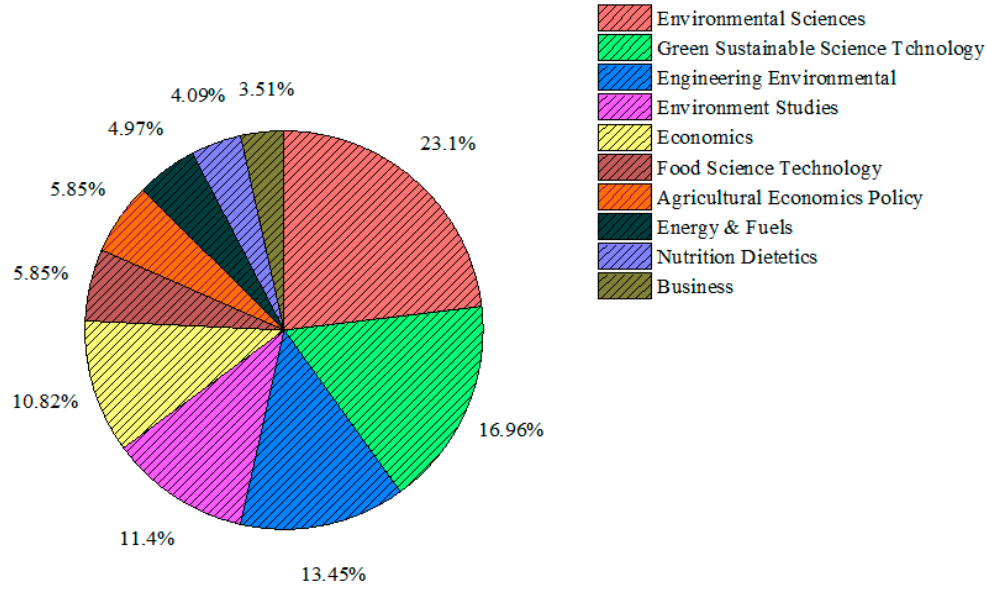
Figure 4. Top 10 subject categories.